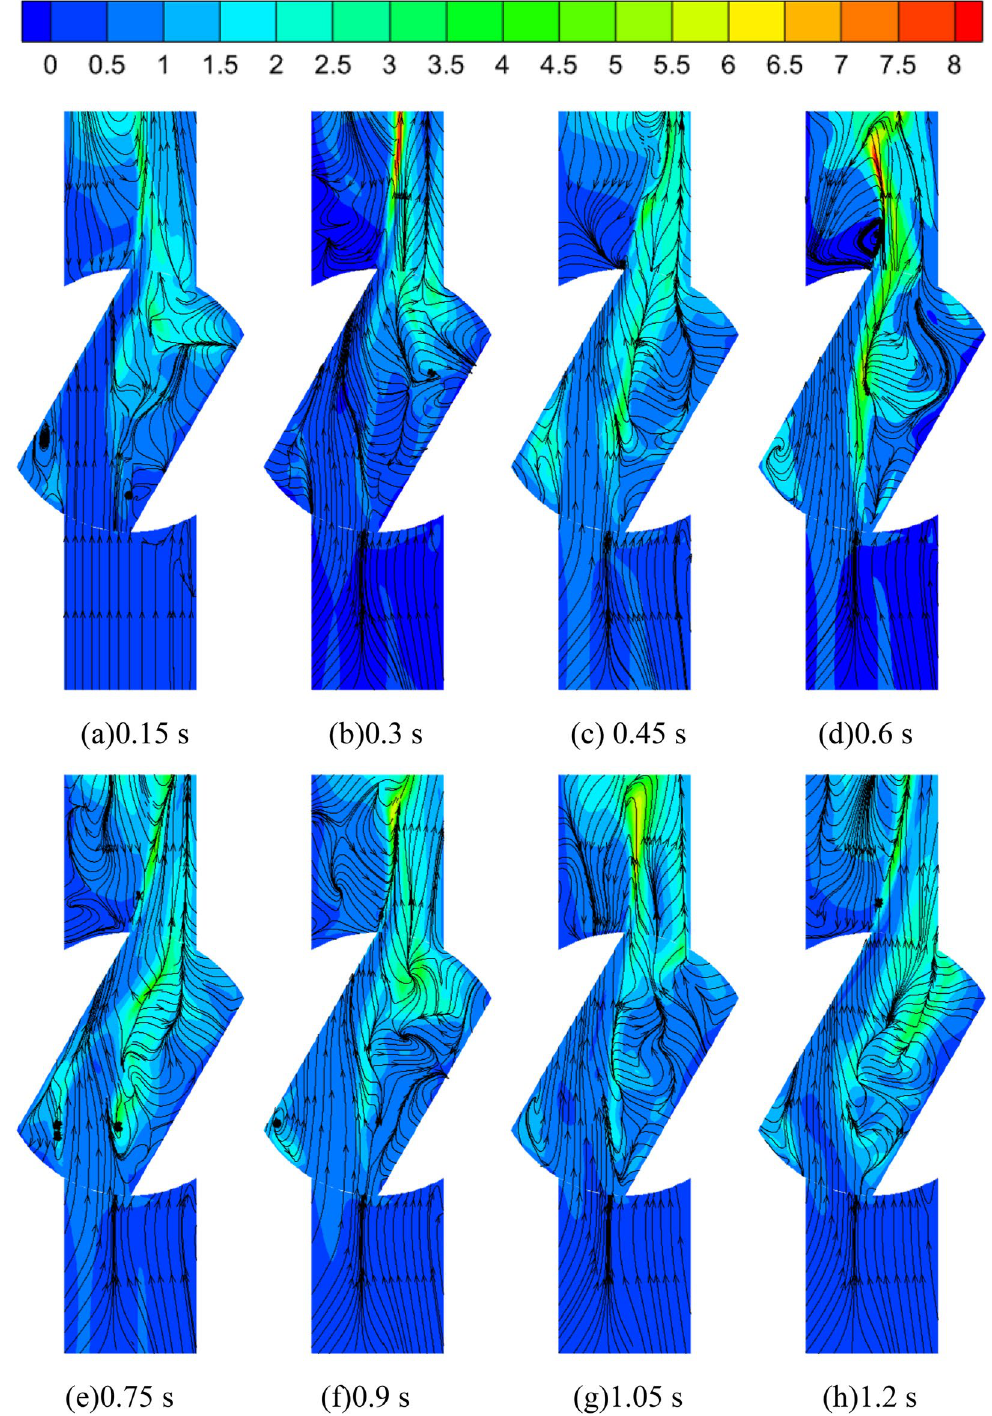
Figure 23. Turbulent kinetic energy distribution of the valve cross-section during medium-speed start-up (m 2 / s 2